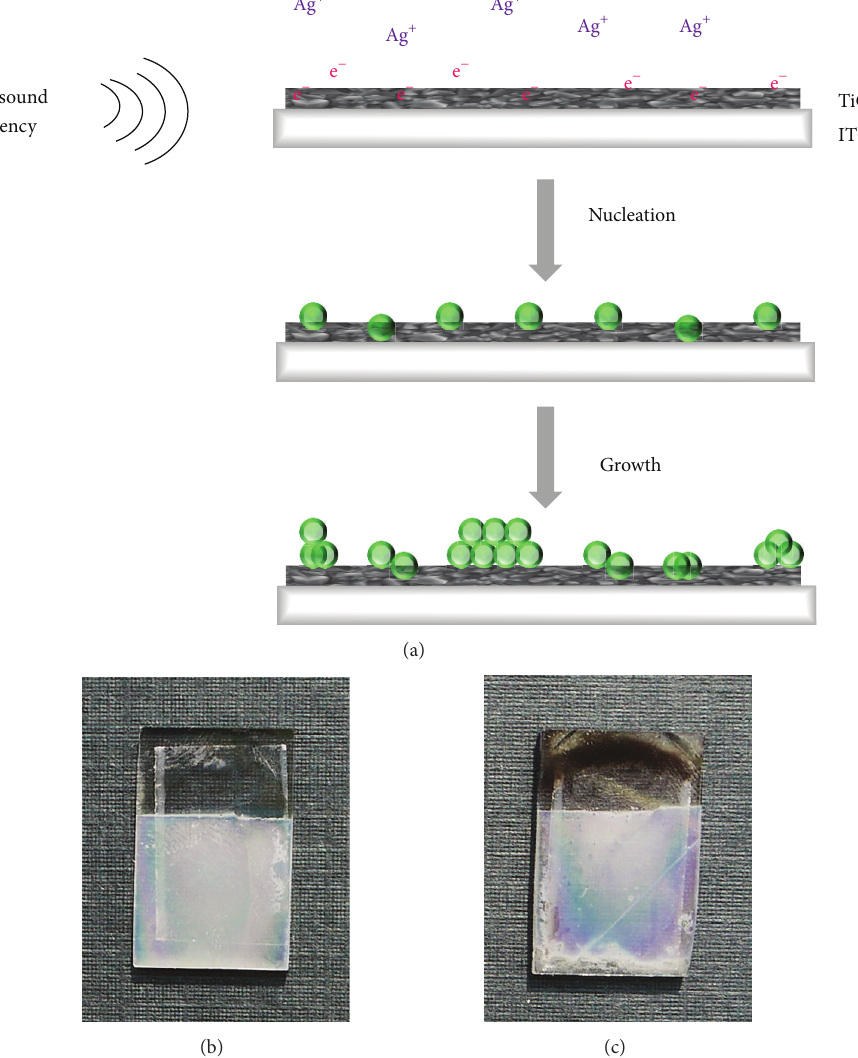
Figure 4: (a) Schematic of the mechanism for the growth of Ag on TiO 2 . Physical appearance of (b) TiO 2 and (c) Ag/TiO 2 .